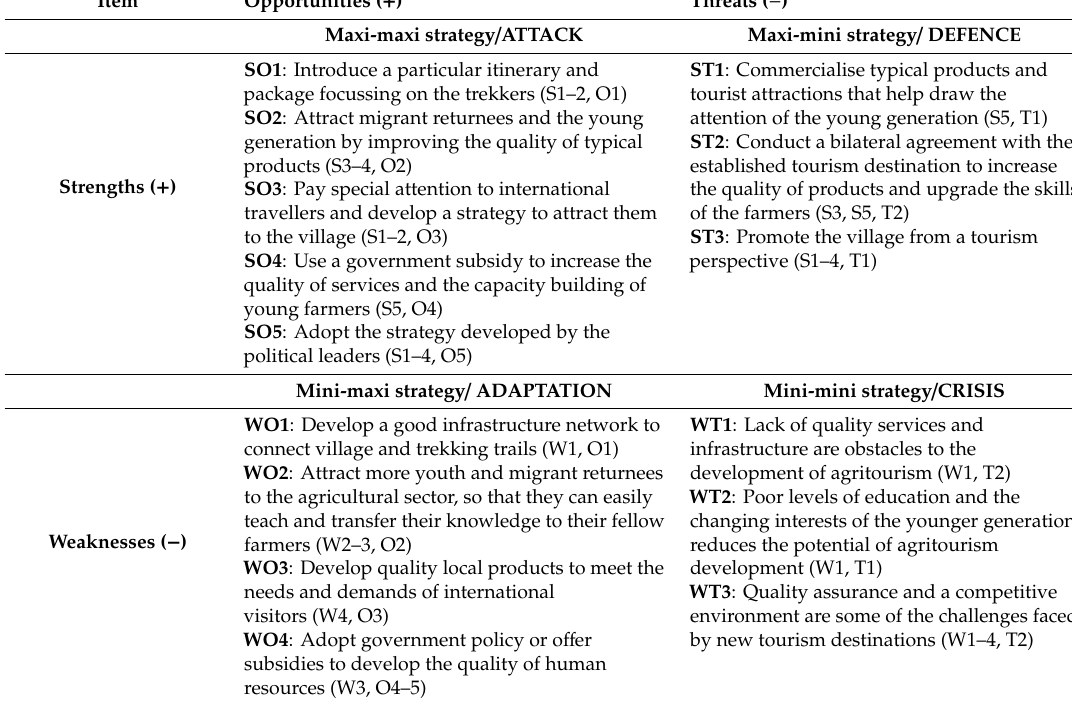
Table 5. Strategic action for agritourism